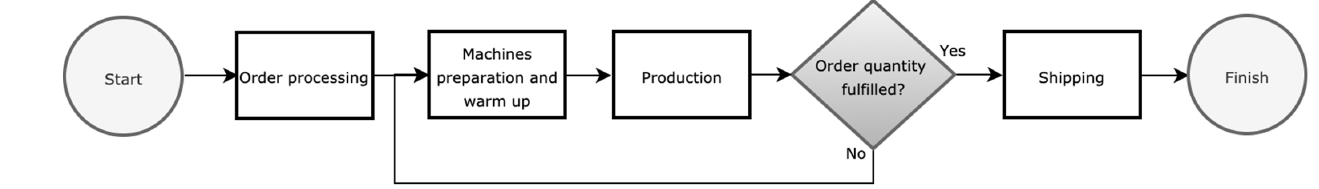
Figure 6. Flowchart of the supply chain configuration with AM only.